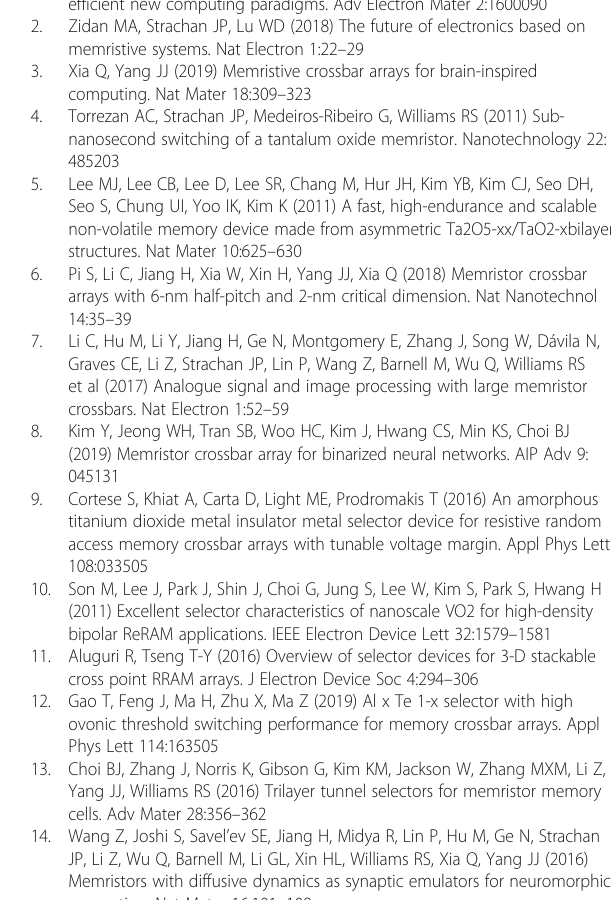
Additional file 1: Figure S1 . The surface morphology of Ag-doped HfOx devices. a)-d) exhibit AFM images in each device. RMS roughness